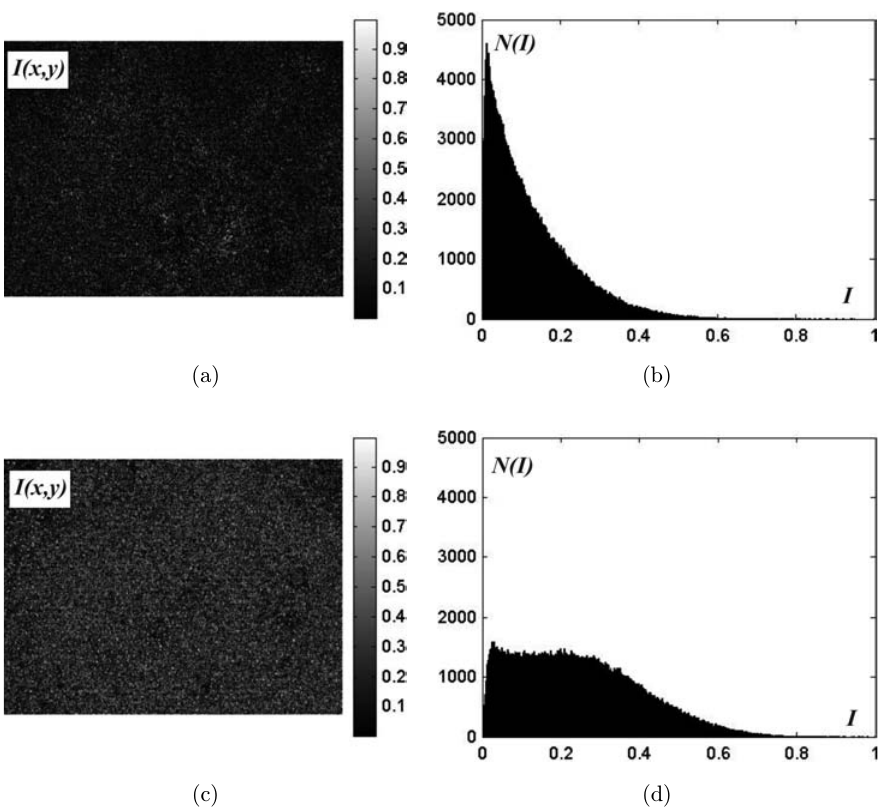
Fig. 4. Coordinate ( I ð x ; y Þ ) and statistical ð N ð I ÞÞ distributions of laser auto°uorescence intensities of cytology smears of cervix uteri mucous coat in precancer state (parts (1), (2)) and cervical microinvasive carcinoma (parts (3), (4)) for the polarization- optimal probing (cid:4) 0 ¼ (cid:3) (cid:4) 0 . Explanations are in the text.